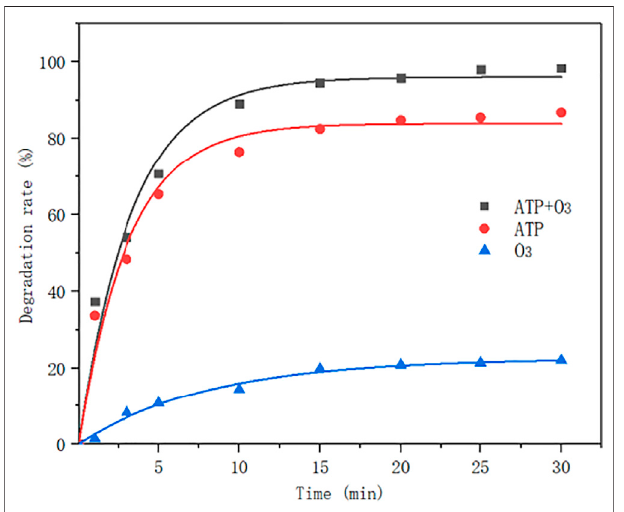
FIGURE 7 | Effect of reaction temperature on MB degradation